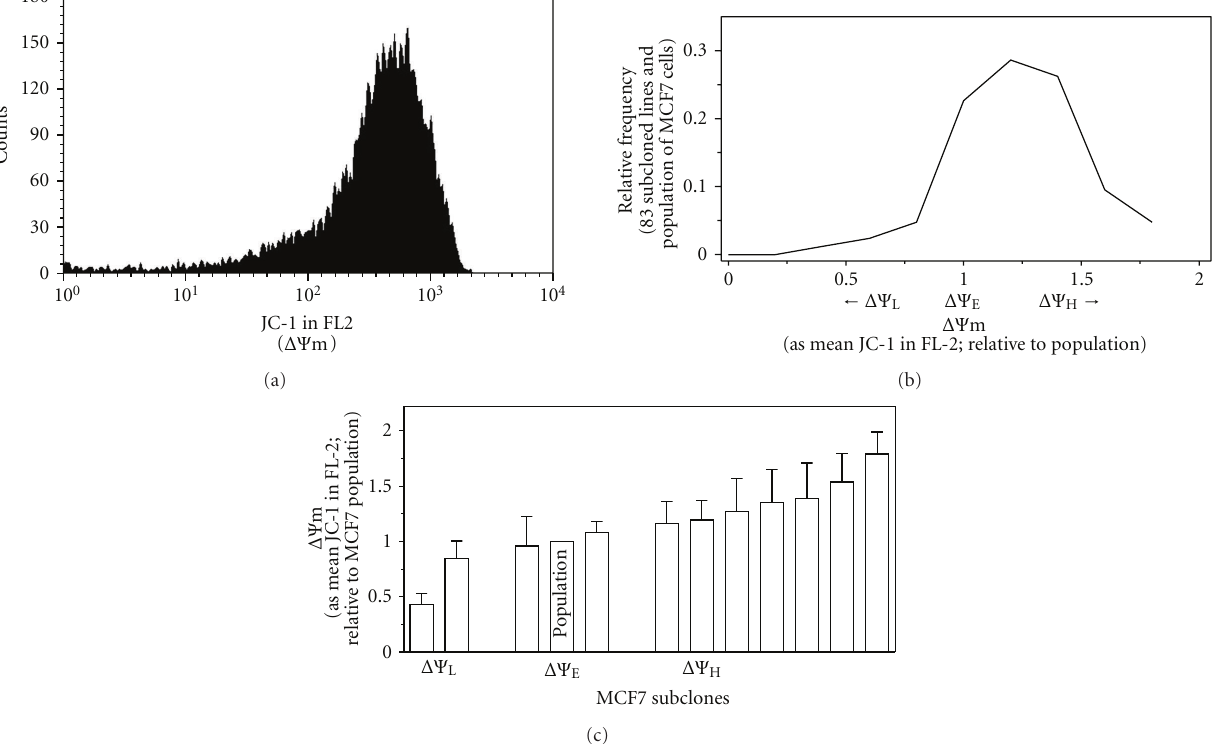
Figure 2: Subpopulations of cells within primary mammary carcinoma cell population exhibit stable di ff erences in intrinsic ΔΨ m. (a) The MCF7 cell line stained with jc-1 and analyzed by flow cytometry in FL-2. (b) The parental population of MCF7 and 83 subcloned cell lines were stained with JC-1, analyzed by flow cytometry, the Intrinsic ΔΨ m each subcloned line was expressed relative to that of the unselected population of MCF7 cells and plotted as a frequency distribution. (c) 11 subcloned cell lines derived from SW480 cells were selected from further study. Mean and SEM of triplicate ΔΨ m determinations made over approximately 3 months. Lower intrinsic ΔΨ m are statistically di ff erent from higher intrinsic ΔΨ m (Bonferroni’s Multiple Comparison Test; P ≤ 0 .